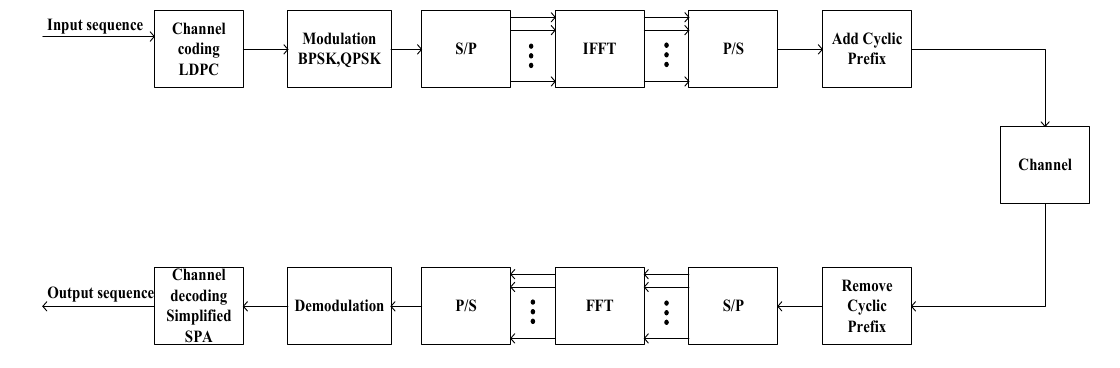
Figure 1. Receive and transmit operations.